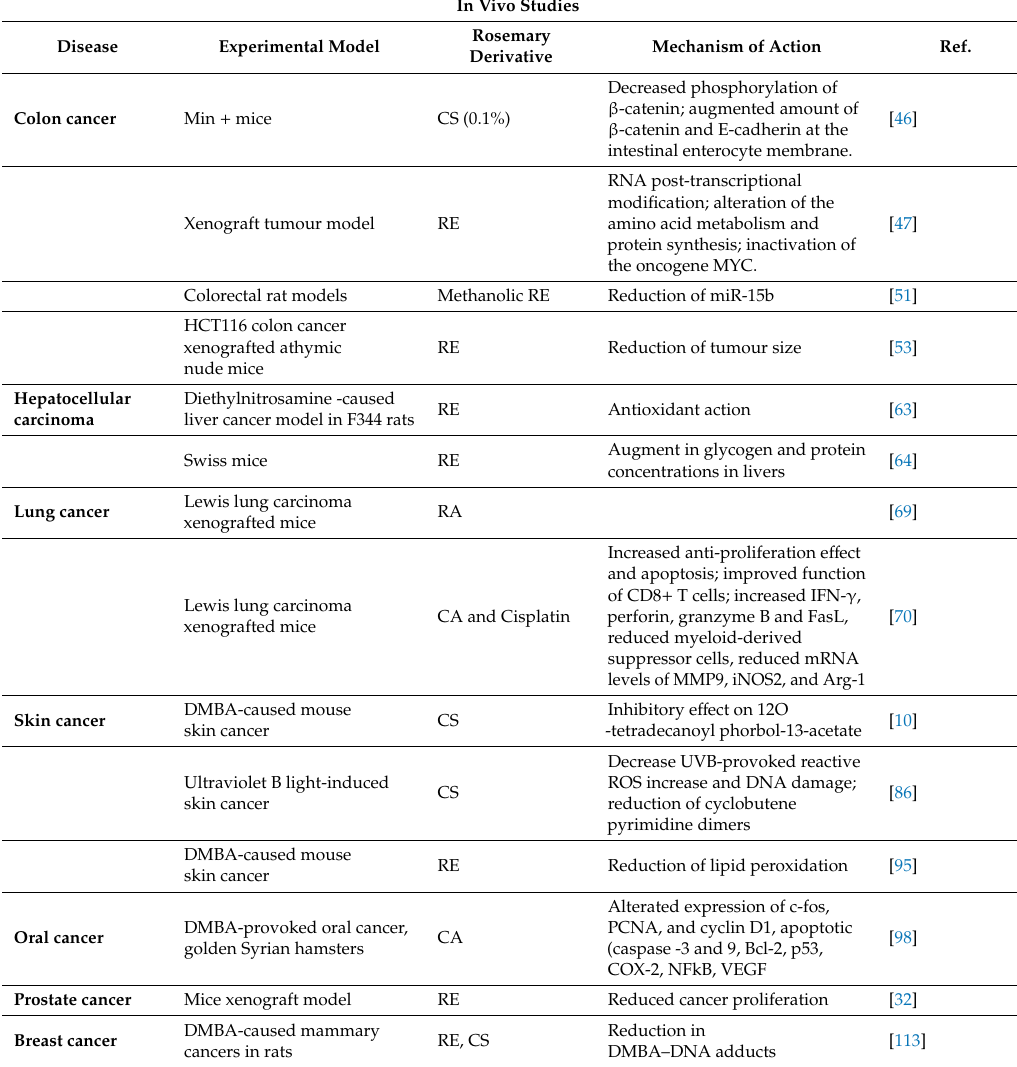
Table 1. In vivo studies on the antineoplastic e ff ects of Rosemary. In Vivo